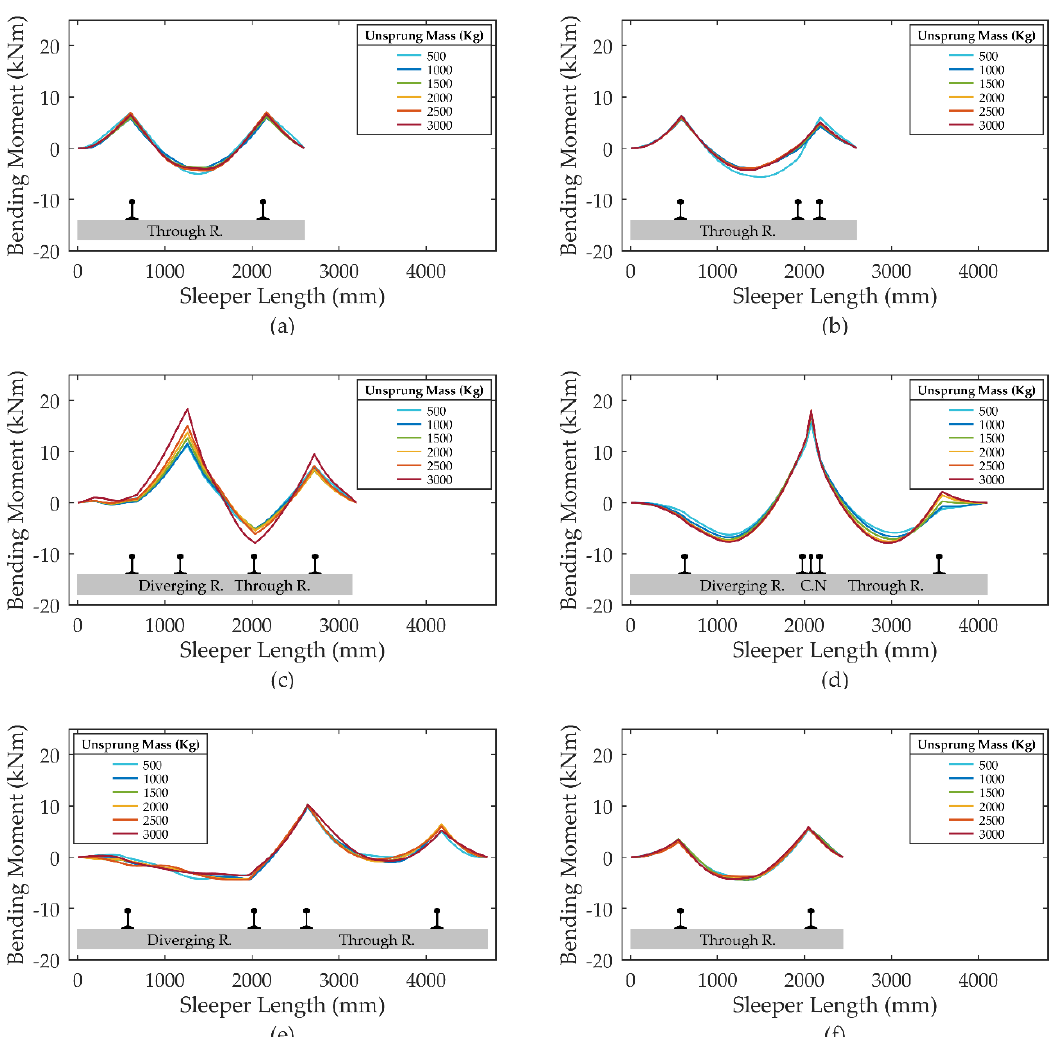
Figure 18. Bending moment distributions of specific sleepers with reference to wheel loads: ( a ) sleeper at the entrance; ( b ) sleeper under the switch blades; ( c ) sleeper at the closure panel; ( d ) sleeper under the crossing nose; ( e ) the longest sleeper; ( f ) the shortest sleeper.